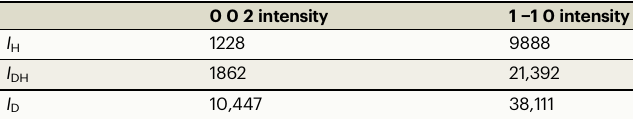
Table 2 | Calculated intensities of re fl ections (002) and (1 − 1 0) for a unit cell containing only H chains, I H (hkl), only D chains, I D (hkl), and containing equal amounts of H and D chains (each withhalfoccupancyatthetwo chain positionsintheunit cell), I DH (hkl), using the previously reported atomic coordinates of cellulose II 5 and the program SHELX 17 0 0 2